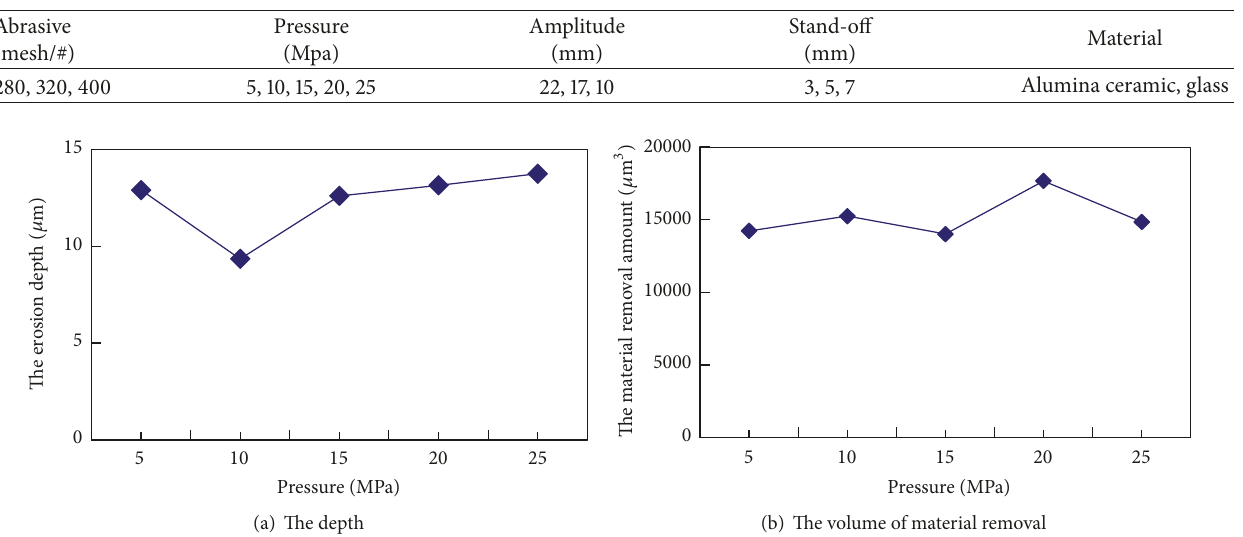
Table 3: The experiment parameters.